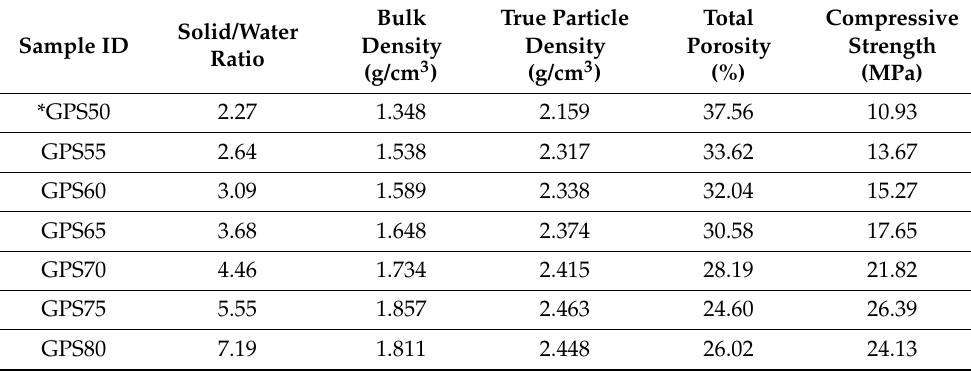
Table 2. Physical and mechanical properties of GP